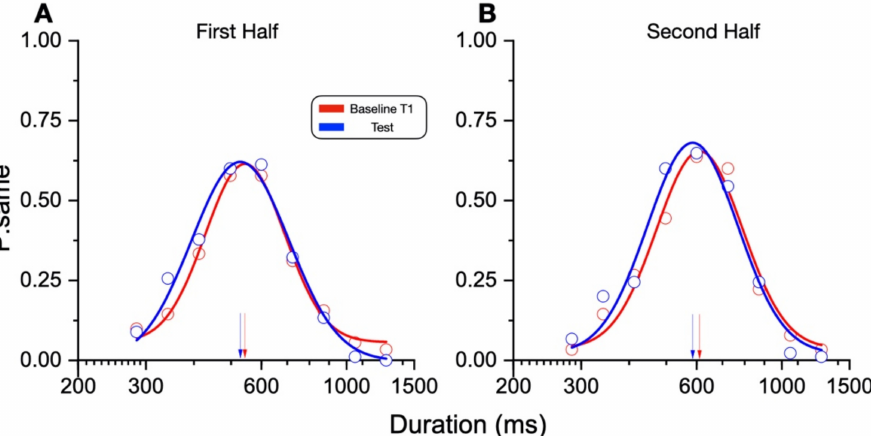
Figure 6. Duration perception after running. As in Figure 3B, stimuli durations were plotted against the proportion of “same” responses and fitted with Gaussian functions with the peak of the fits (arrows) corresponding to the test duration matched with the reference (600 ms). Blue curves report the aggregate data before running (baseline T1), the red curves the data collected after the running phase. To test whether the effect was detectable in the very first trials after the run phase, the analyses were performed on two sub-set of the data: the first ( A ) and second half ( B